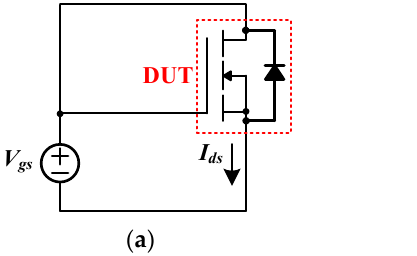
Figure 5. Measurement circuits ( a ) V th ( b ) R on .